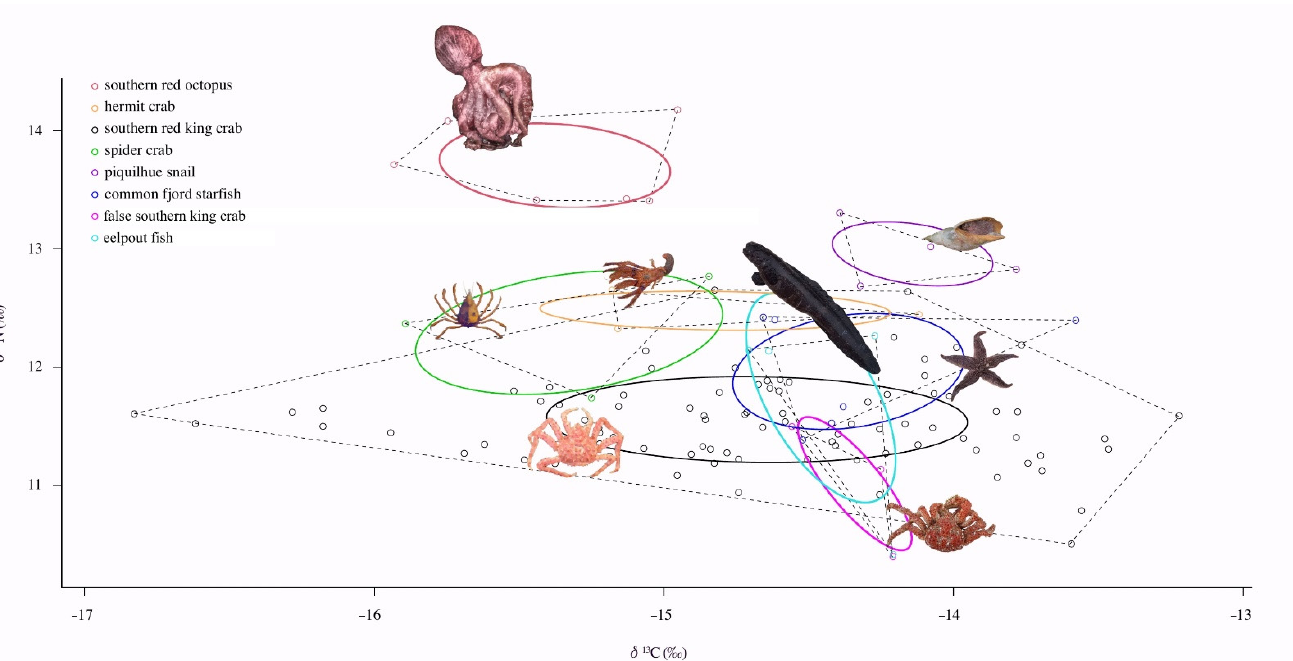
Figure 8. Community niche width output for the associated fauna species and the southern king crab Lithodes santolla using SIBER analysis. The standard ellipse area (SEA) represents the isotopic niche width of each species. SEA = solid lines and convex hulls of the total area (TA) = dashed lines.